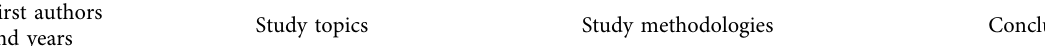
Table 2: Characteristics of the included